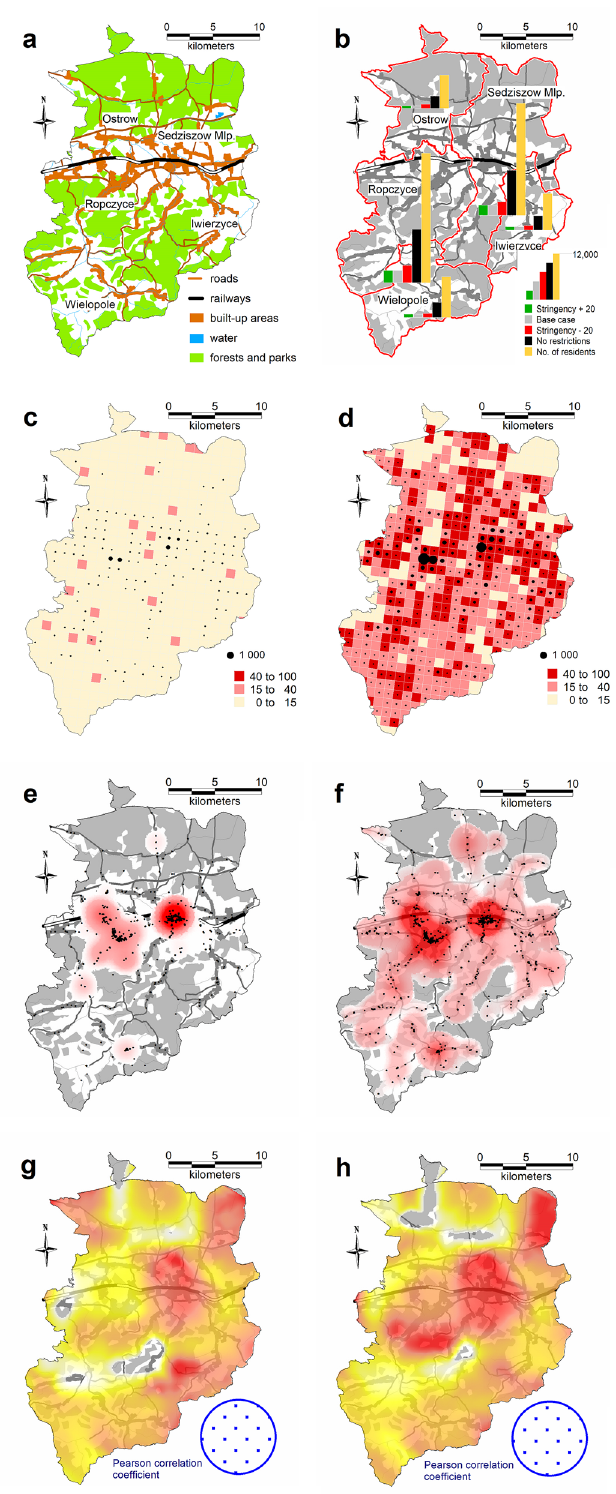
Figure 6. Spatial distribution of the number of cases, their locations, and the differences between individual models in the Ropczyce- Sędziszów powiat . (a) Ropczyce-Sędziszów powiat : land cover. ( b ) The number of cases in 4 models in the gminas in relation to the number of inhabitants of these gminas. ( c ) The number of cases in a 1 × 1 km grid (pie chart) and the percentage of cases (intensity of red color): the base case model. ( d ) The number of cases in a 1 × 1 km grid (pie chart) and the percentage of cases (intensity of red color): the no restrictions model. ( e ) The location of cases (black dots) and the density of cases by place of infection: the base case model. ( f ) The location of cases (black dots) and the density of cases by place of infection: the no restrictions model. ( g ) The Pearson correlation coefficient between the place of infection and the number of inhabitants in the area (white < 0.5, yellow < 0.75, red ≥ 0.75): the base case model. ( h ) The Pearson correlation coefficient between the place of infection and the number of inhabitants in the area (white < 0.5, yellow < 0.75, red ≥ 0.75): the no restrictions model (developed by the authors in QGIS ver.